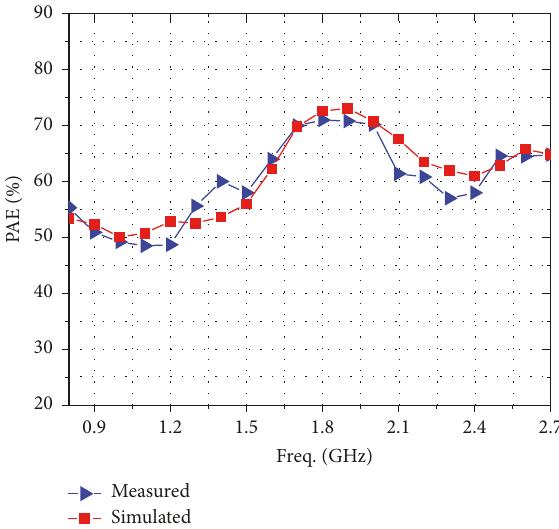
Figure 10: Measured and simulated PAE versus frequency.